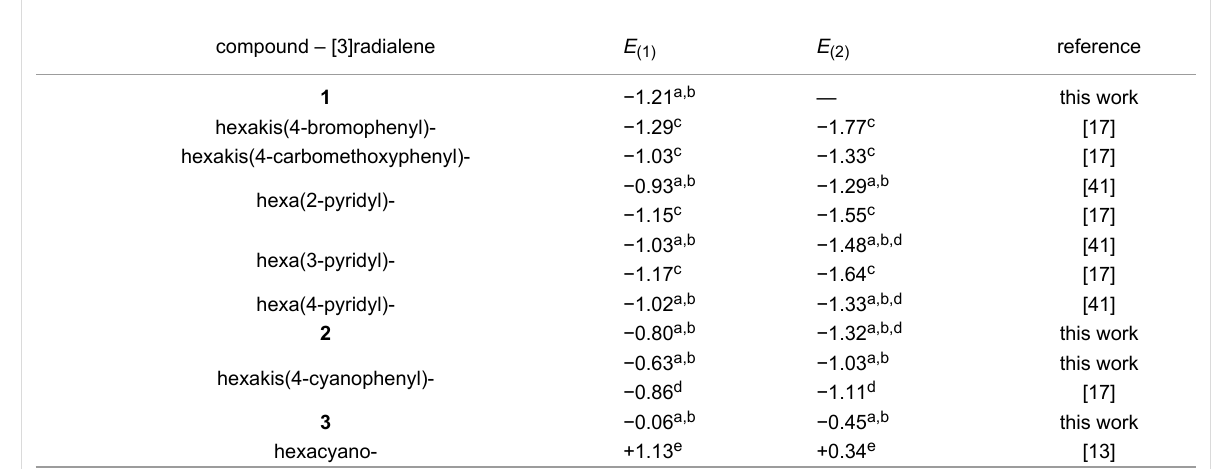
Each [3]radialene forms three lone pair-nitrile to electron defi- cient [3]radialene core carbon contacts [22-26] within the struc- ture, with distances of 3.205, 3.219 and 3.267